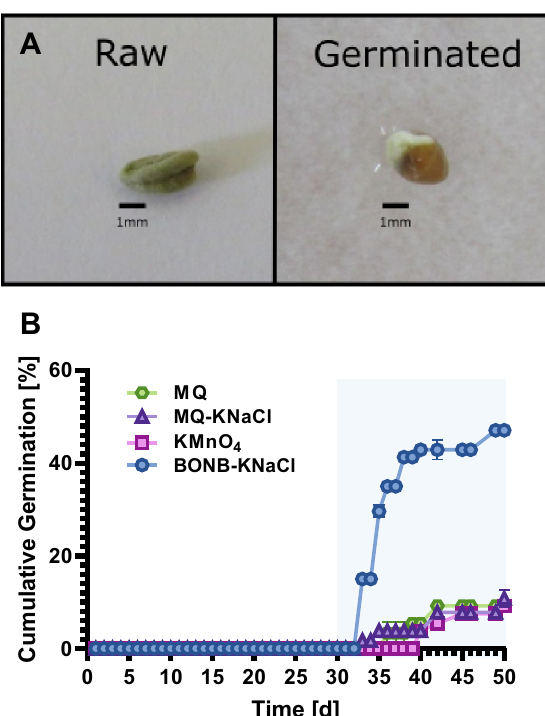
Figure 1. Average cumulative germinations of experiment 1. ( A ) Left image shows an example of a raw seed; right image shows a germinated seed. ( B ) Cumulative germination rates of wasabi seeds after conditioning in treatment solution: MQ (milli-Q water), MQ-KNaCl (milli-Q water containing K + , Na + , and Cl − ), KMnO 4 solution, and BONB-KNaCl (bulk oxygen nanobubble solution containing K + , Na + , and Cl − ). Figure shows mean data from duplicate experiments. Error bars indicate standard errors. Data points without error bars indicate no standard